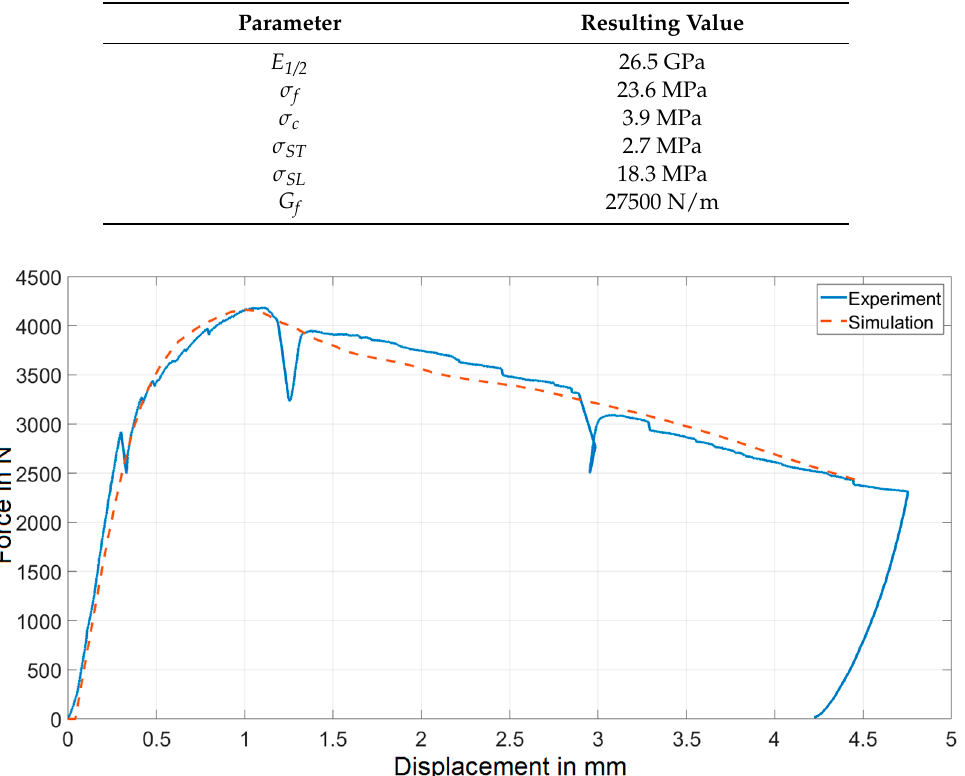
Figure 7. Comparison of force-displacement curves resulting from the experiment and resulting from simulations using inverse analysis . Table 1. Parameter estimates resulting from the inverse analysis.